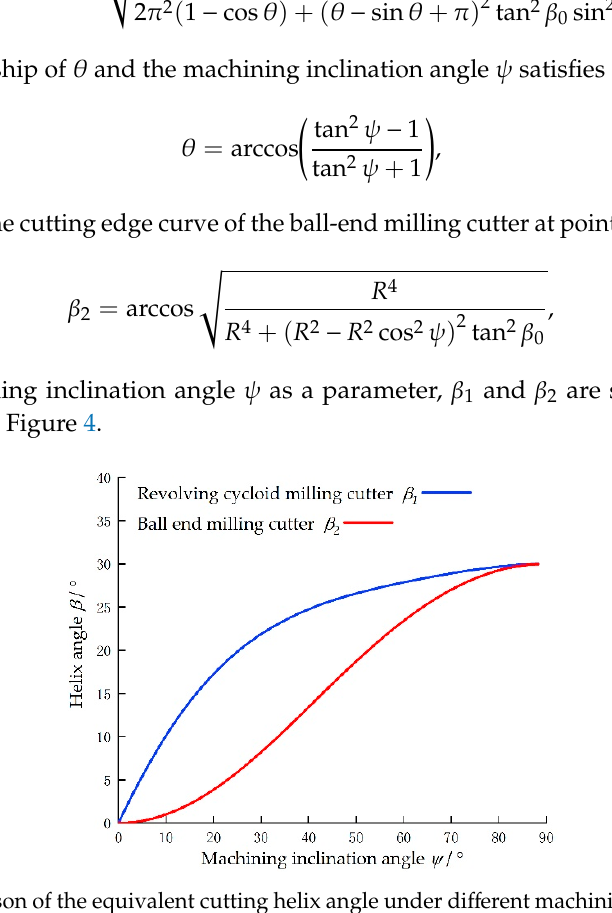
Figure 4. Comparison of the equivalent cutting helix angle under different machining inclination angle.